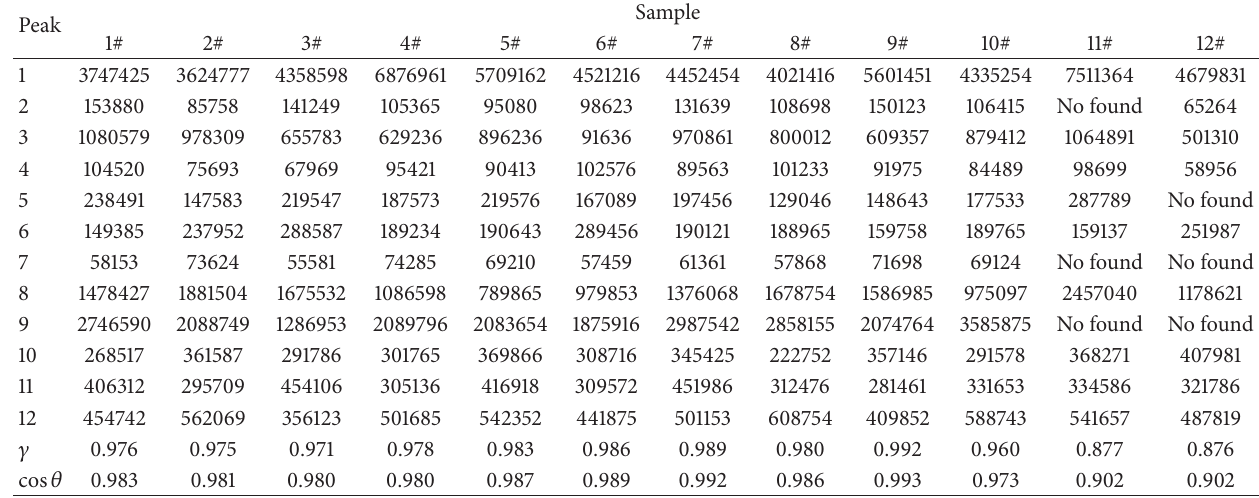
Table 4: Peak area of various samples analyzed by CE-copper